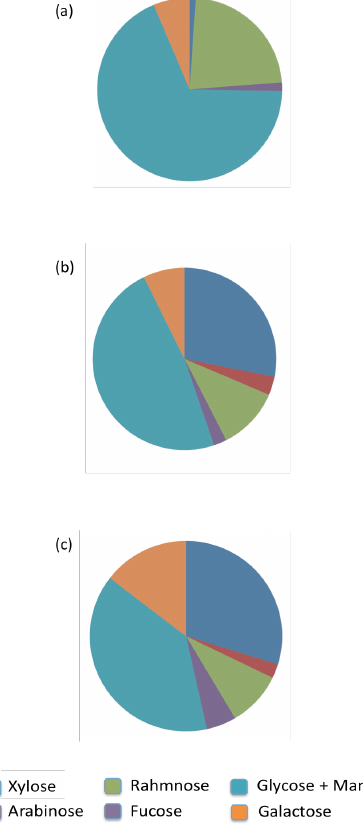
Fig. 7. Relative percentage of monosaccharides determined (a) in the Aitken and accumulation mode (BCI stage 1 and 2, 0.035– 0.665µm) during DOY 242 (a sample most likely influenced by continental combustion sources); (b) during the PI-drift, Aitken and accumulation mode (BCI stage 1 and 2, 0.035–0.665µm); and (c) Figure 7. Relative percentage of monosaccharides determined: (a) in the Aitken - and 4 from bubble-generated sea spray aerosol at open lead site accumulation mode (BCI stage 1 and 2, 0.035-0.665 µ m) during DOY 242 (a sample most likely 5 influenced by continental combustion sources), (b) during the PI-drift, Aitken - and accumulation 6 mode (BCI stage 1 and 2, 0.035-0.665 µ m), and (c) from bubble generated sea spray aerosol at 7 open lead site ( < 1 µ m). 8